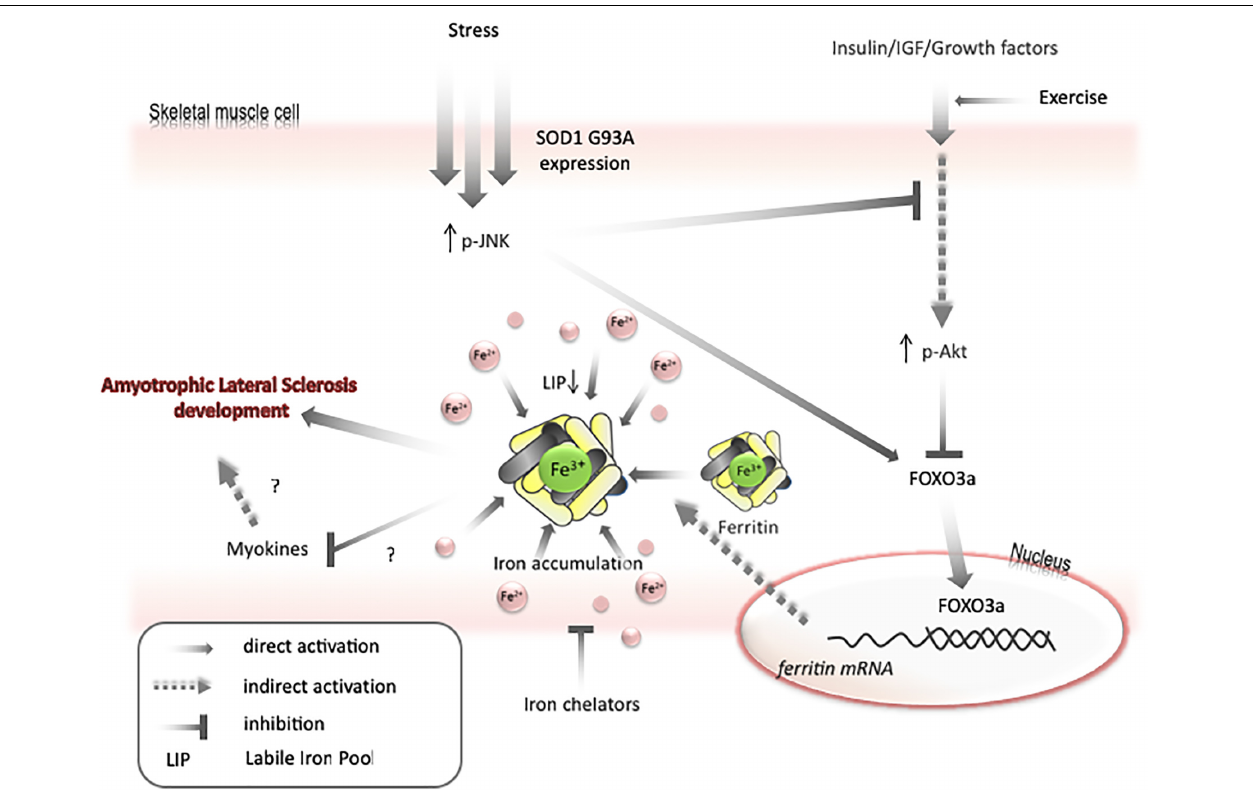
FIGURE 3 | Model for mechanisms of iron accumulation in muscle. Expression of SOD1 G93A or other stresses lead to activation of JNK and inactivation of Akt. It results in activation of FOXO3a transcriptional factor. FOXO3a upregulates ferritin H expression that can cause decrease in labile iron pool and upregulate iron transport into a cell. Iron accumulation may negatively affect myokines synthesis and increase motor neuron vulnerability to degeneration. Exercise can prevent AKT inactivation and iron chelators can diminish skeletal muscle